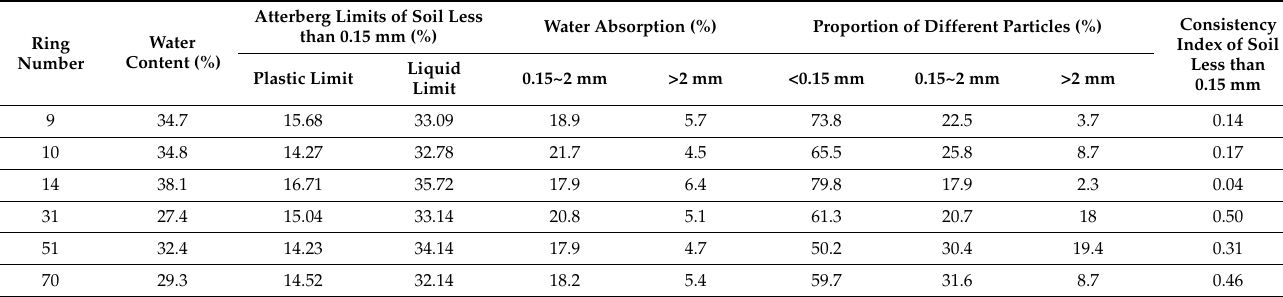
Table 2. The test result of soil.